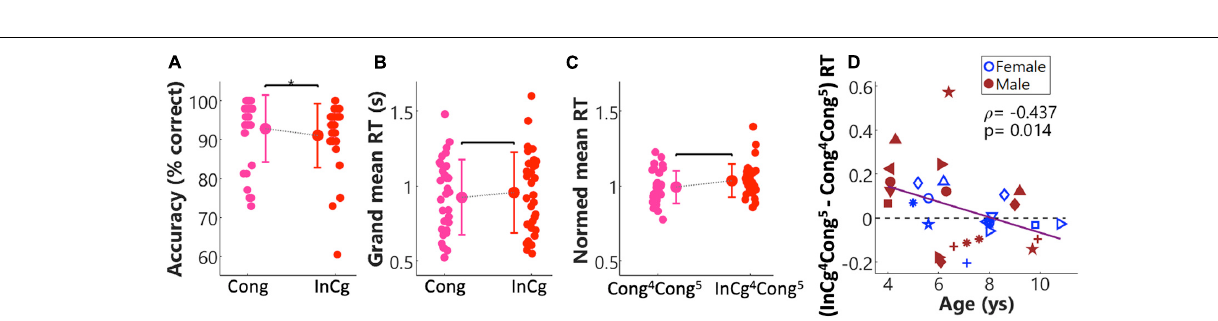
FIGURE 6 | Behavioral results from the fNIRS session. Panels (A–C) show the response accuracies, grand reaction times (RTs) across all events and RTs for event 5, respectively, in the congruent (pink) and incongruent (red) conditions. Each panel shows the correlation between the ages of children and their performance. The group means (markers) and standard deviations (SD, bars) for each condition are shown in each panel. Panel (D) shows the correlation between the ages of children, and normalized differences in RT for event 5 between the incongruent and congruent conditions, i.e., (InCg 4 Cong 5 – Cong 4 Cong 5 ) RT. For individuals, the symbols used here were the same as in Figure 1